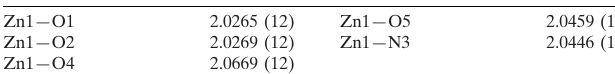
Selected bond lengths (A˚ ).